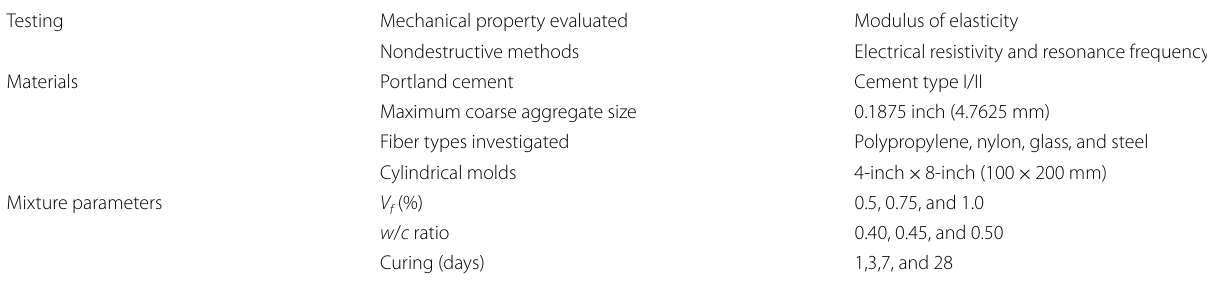
Table 1 Materials, methods, and mix parameters for experimental investigation.